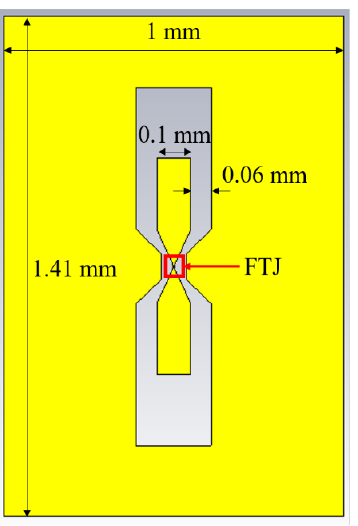
Figure 10. Noise equivalent power (NEP) in the two states of the DC switch: ( a ) OFF (reverse bias) and ( b ) ON (forward bias).